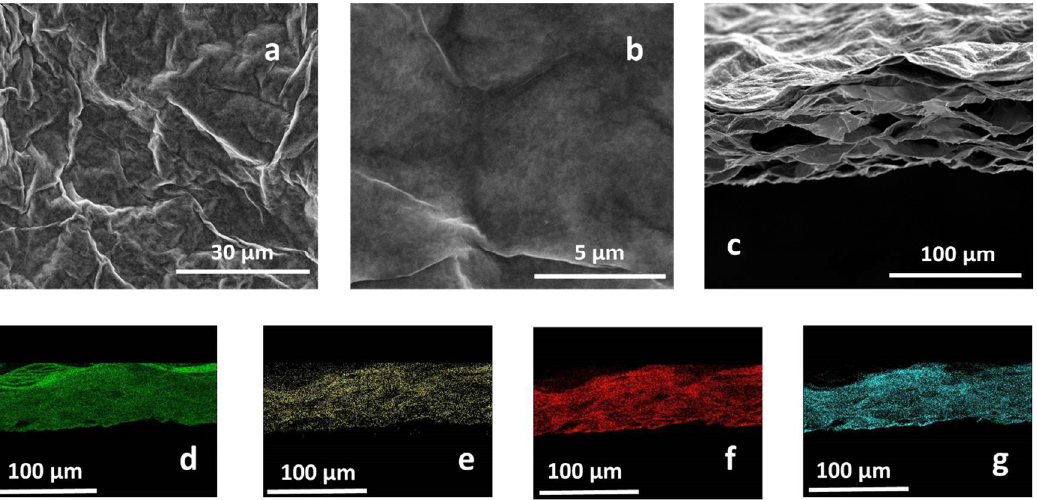
Figure 2. Secondary electron SEM images of the MMT/rGO film surface ( a , b ) and cross-section ( c ). EDX mapping of the film cross-section, evidencing the homogeneous distribution of Al ( d ), C ( e ), O ( f ), and Si ( g ).